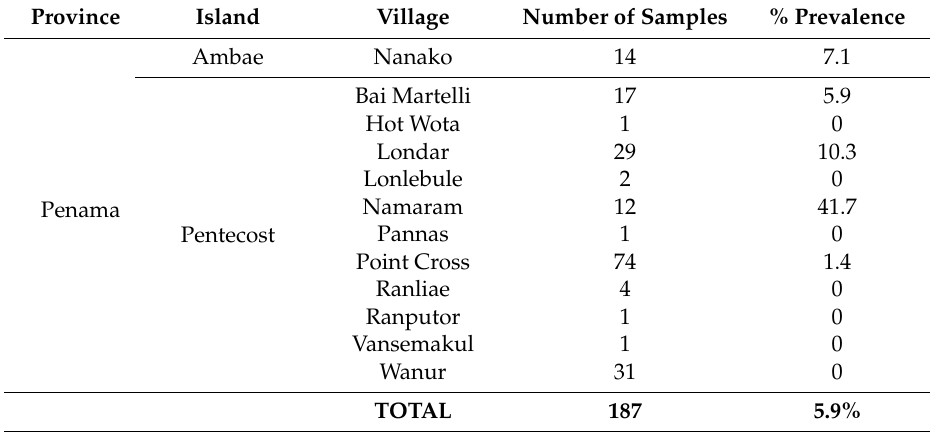
Table 2. 2008 Targeted Child Survey, number of samples taken from children aged up to 10 years of age and the prevalence of Bm14 antibody as determined based on cut-off 1 (original